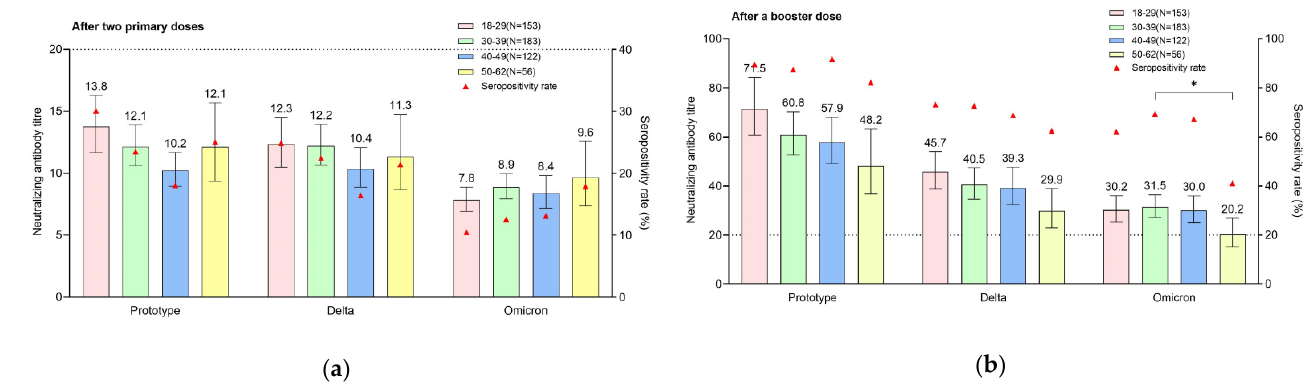
Figure 4. Neutralizing antibody titer against SARS-CoV-2 wild-type strain, and Delta and Omicron variants between different age groups: ( a ) neutralizing antibody titer after two primary COVID-19 inactivated vaccine doses; ( b ) neutralizing antibody titer after a booster dose(*: p < 0.05).